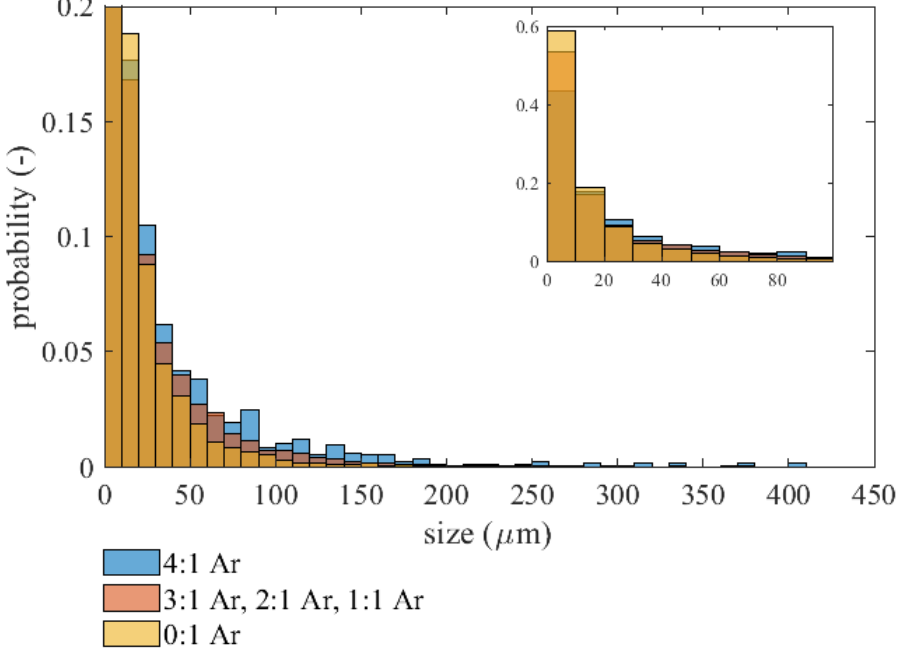
Figure 6. Particle size distribution of carbon powders resulting from different H 2 :CH 4 ratio, after extraction from the reactor.